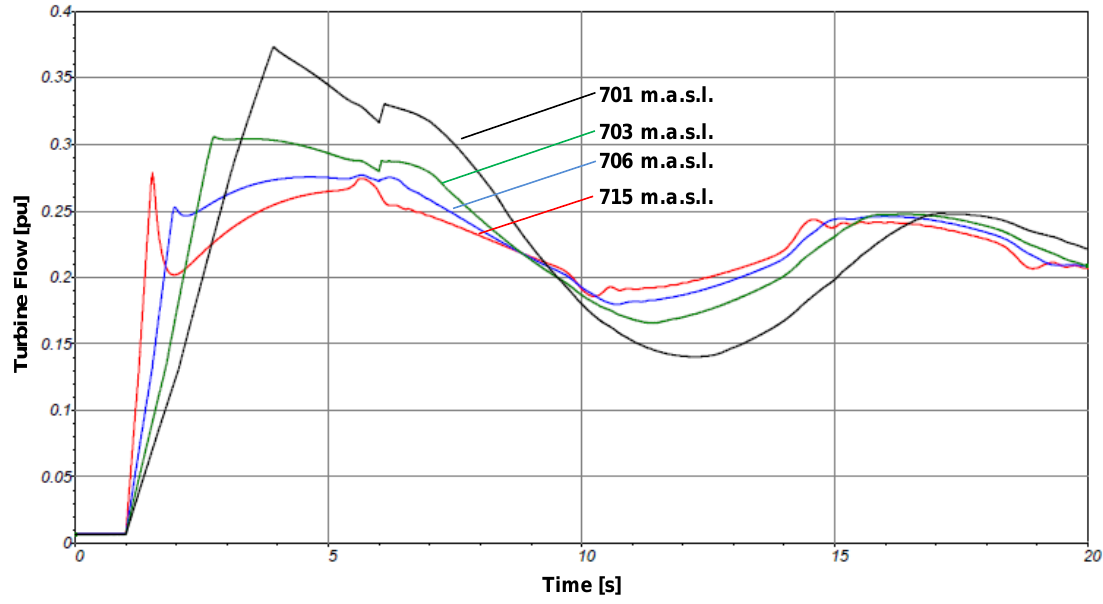
Figure 10. Turbine water flow after a wind generator trip for different upper reservoir levels (20 s) after a 2.3 MW wind generator trip.